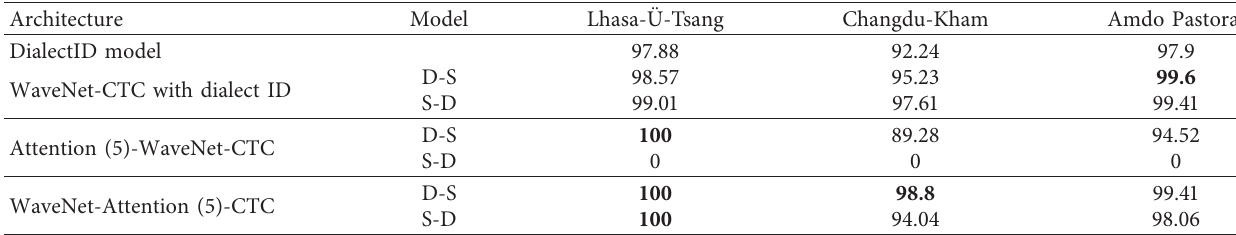
Table 3: Dialect ID recognition accuracy (%) of two-task